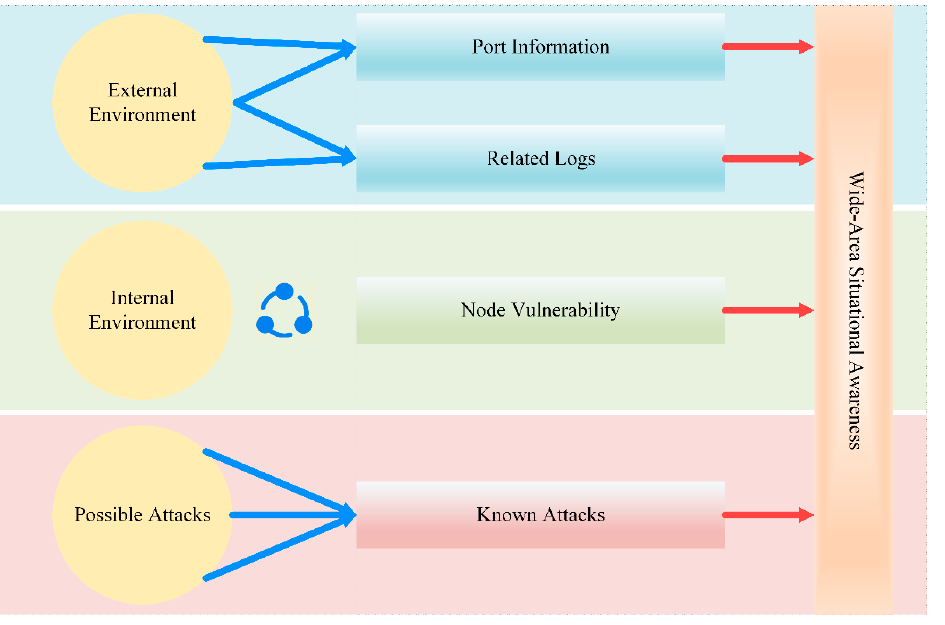
Figure 1. Wide-Area Situational Awareness (WASA).